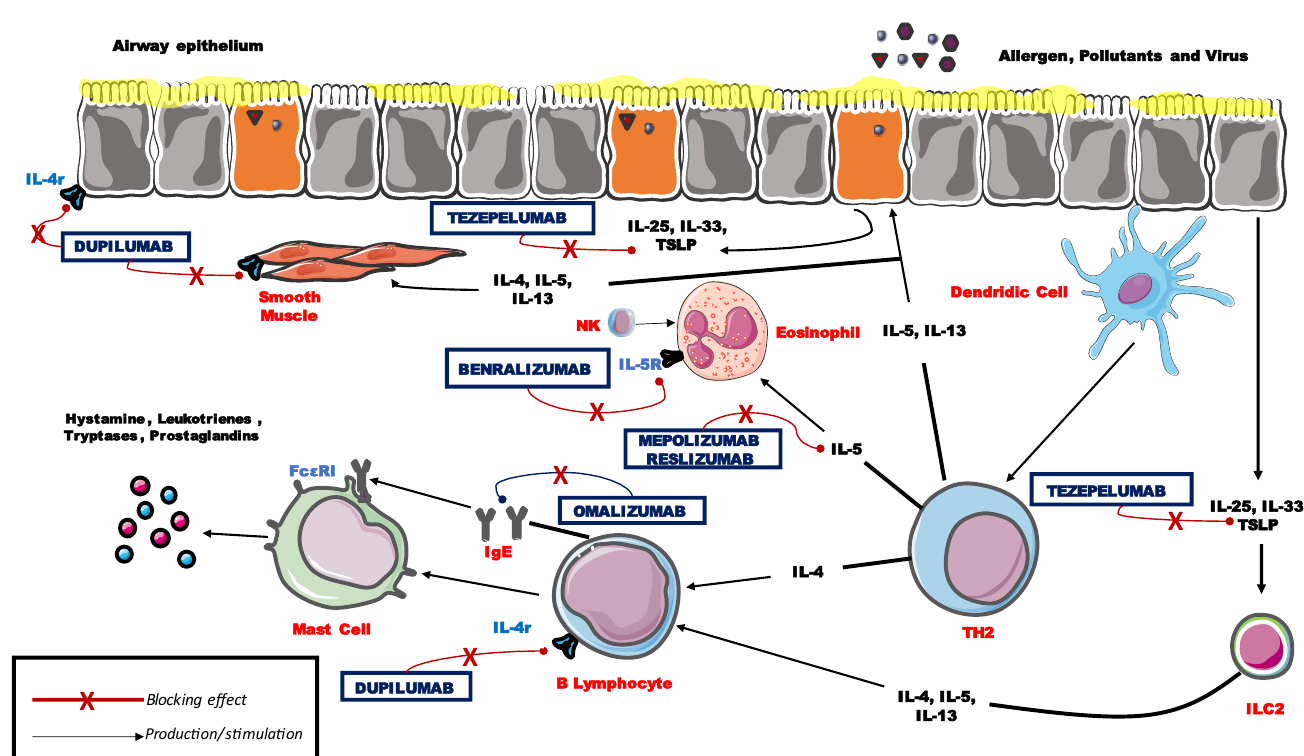
Figure 1. Severe asthma pathway of inflammation and target of MABs.